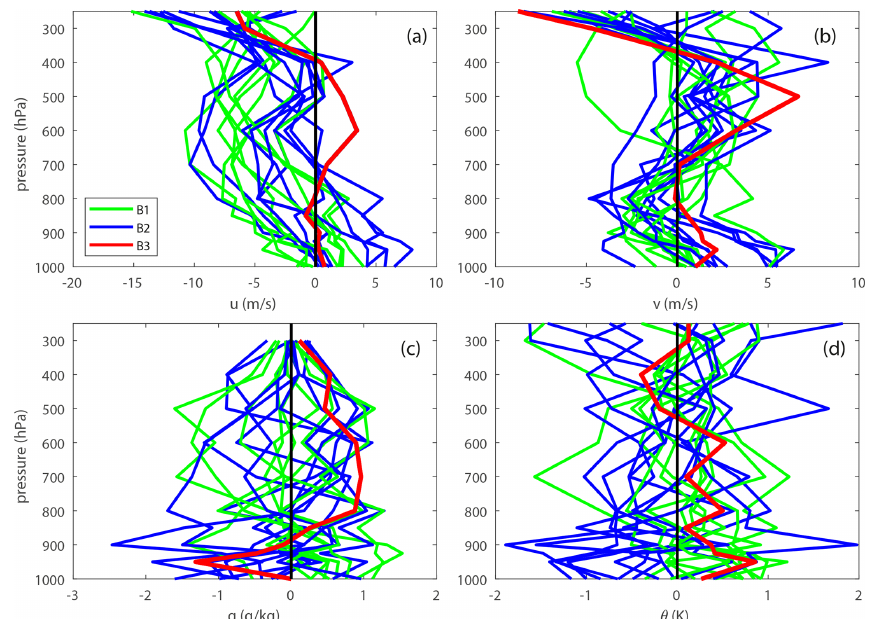
Figure 4. The mean dropsonde observations of (a) zonal wind, (b) meridional wind, (c) water vapor mixing ratio, and (d) potential temper- ature, for each individual flight, for box B1 in green, the box B2 in blue, and the special case in box B3 in red. The mean over the whole campaign has been subtracted from the mixing ratio and potential